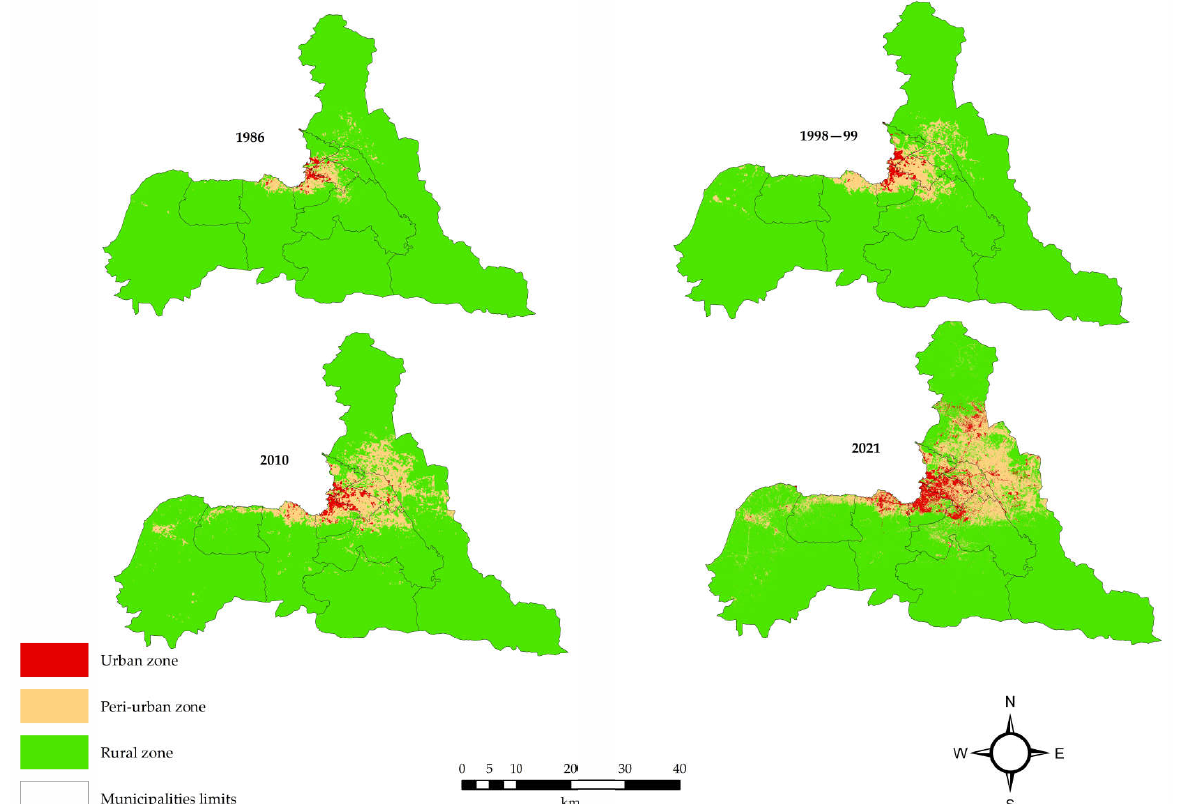
Figure 2. Land cover maps of the Port-au-Prince agglomeration obtained from supervised classifi- cation of Landsat images from 1986, 1998–1999, 2010 and 2021 based on the maximum likelihood algorithm. The black lines correspond to the boundaries of the